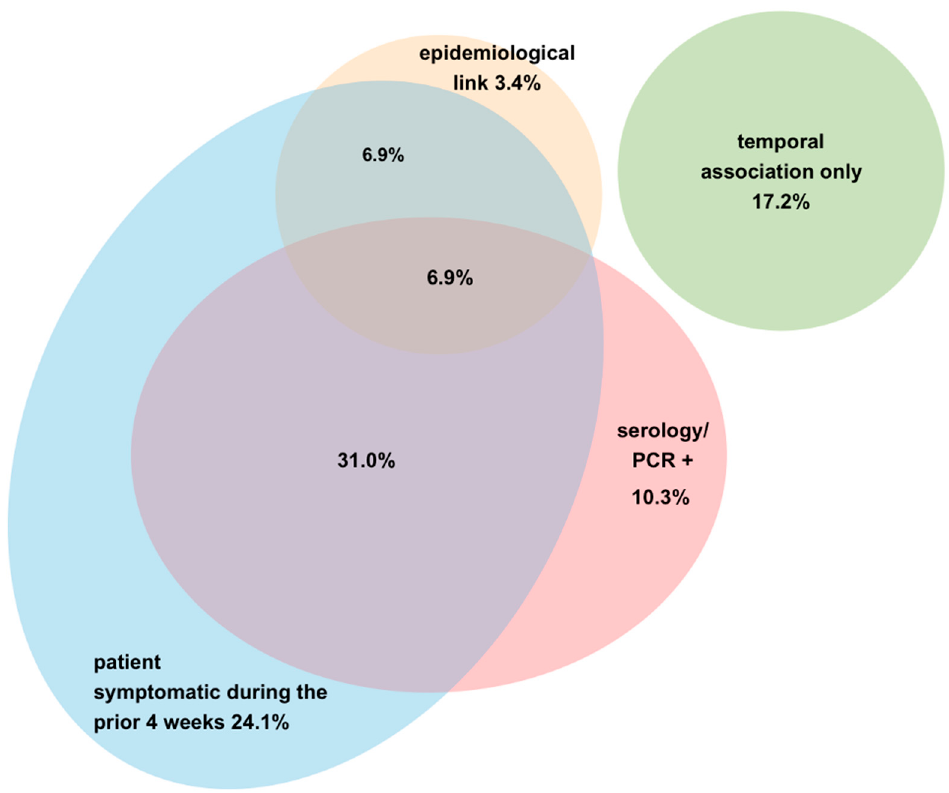
Figure 3. Nature of SARS-CoV-2 exposure to patients included in this cohort.